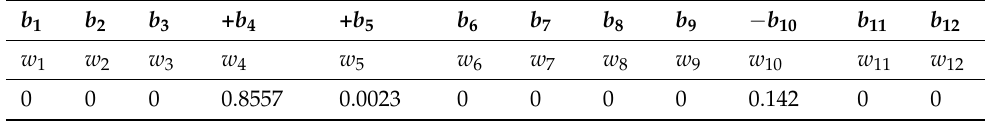
Table 5. Solutions of the portfolio problem (18) and constraint (13).